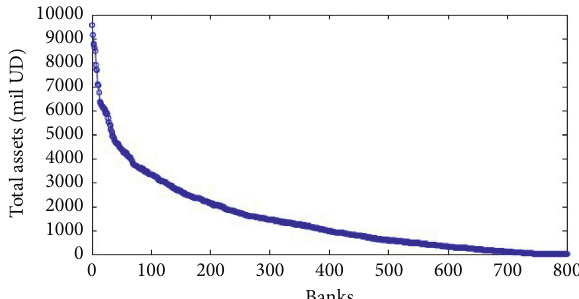
Figure 2: Total assets (mil UD) distribution of banks sorted by global bank ranking.